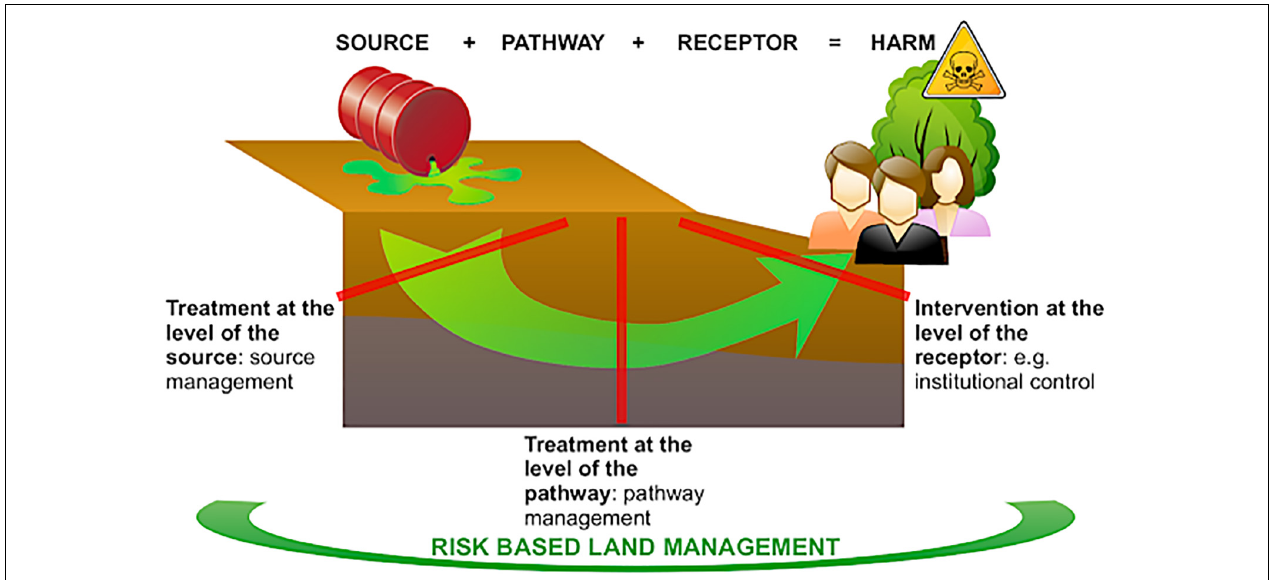
FIGURE 2 | Risk management along a contaminant (S-P-R) linkage (Tack and Bardos,